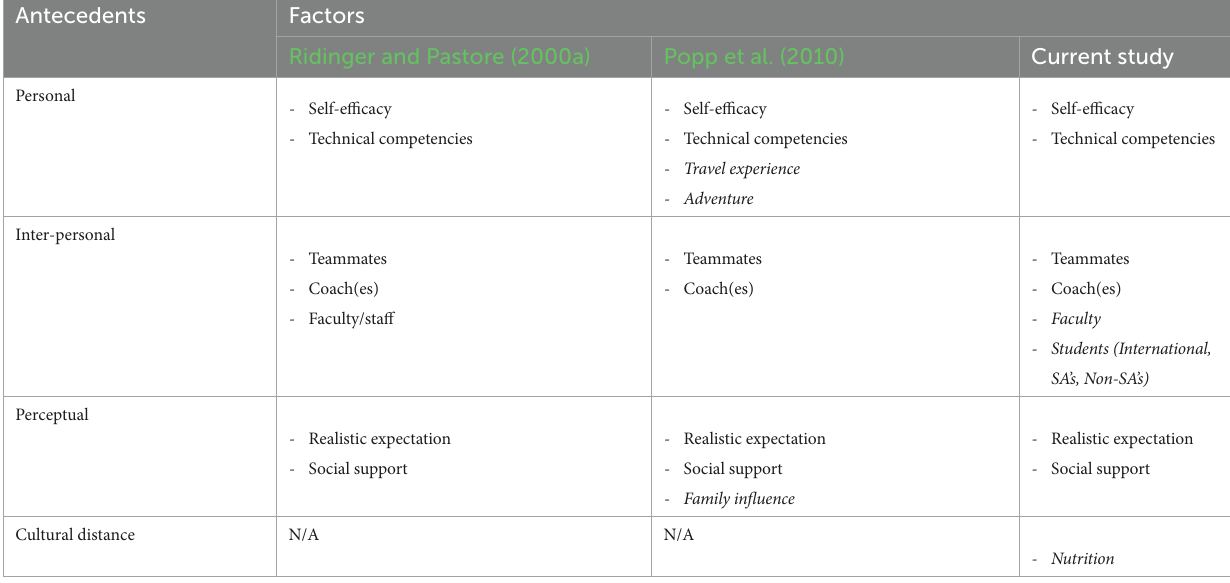
TABLE 1 Comparison of International student-athletes transition adjustment